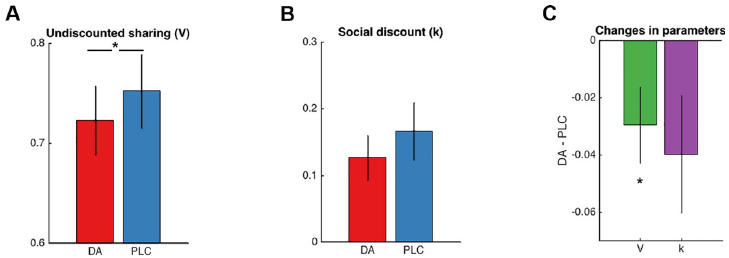
Fig 1. DA receptor agonist pramipexole reduces generosity reference-point (V). Comparisons between conditions show that parameter V representing the overall generosity levels especially to close others, is lower under DA than PLC (t(29) = -2.225, p = 0.034) (A). We observe that parameter k representing social discount showed a difference in trend (t(29) = -1.949, p = 0.061) (B). The condition- comparison between DA and PLC in parameter V and k (C). Error bars represent SEM. � p < 0.05.